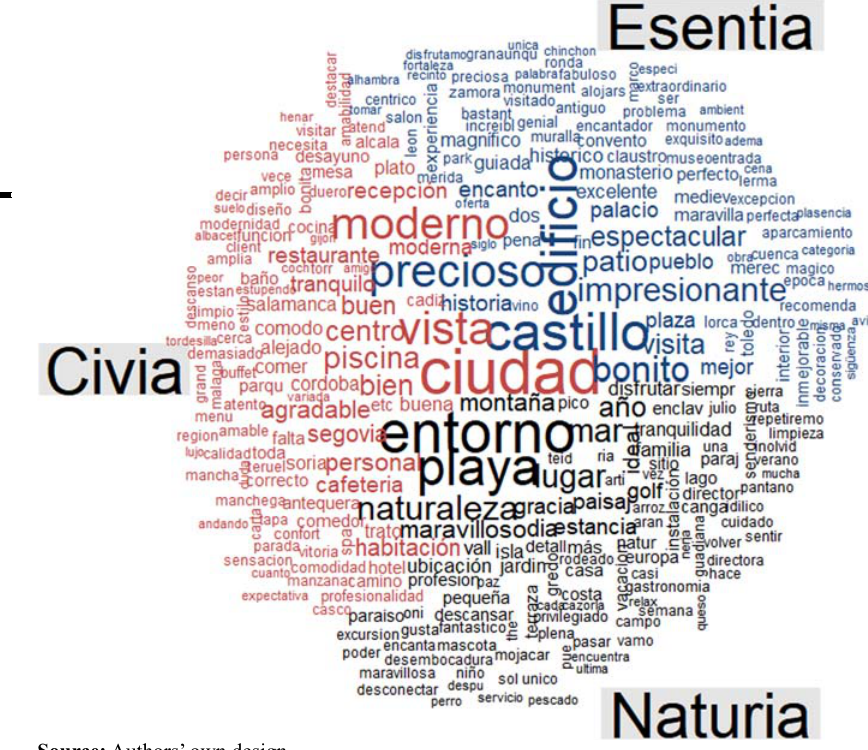
Figure 3. Comparison word cloud